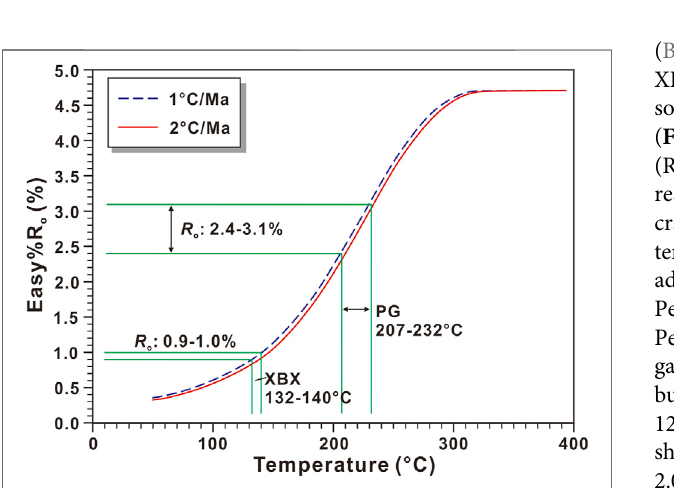
FIGURE3| Thegeneralburialhistoryof (A) wellK2neartheXibeixiangoutcrop(modi fi edfromLuoetal.,2020a)and (B) wellPG5inthePuguanggas fi eld(modi fi ed from Hao et al., 2008). P (cid:1) Permian, T (cid:1) Triassic, J (cid:1) Jurassic, K (cid:1) Cretaceous, N (cid:1) Neogene, Q (cid:1) Quaternary.